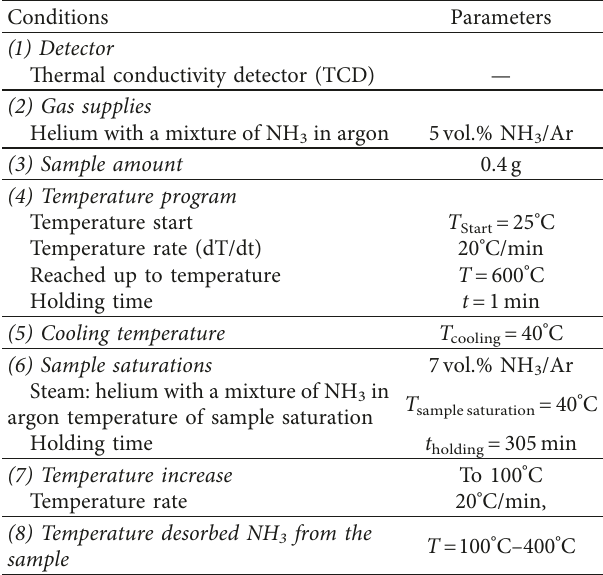
Table 2: Conditions and parameters for characterization of dif- ferent materials like natural zeolites by methyl butynol catalytic test reaction [95,